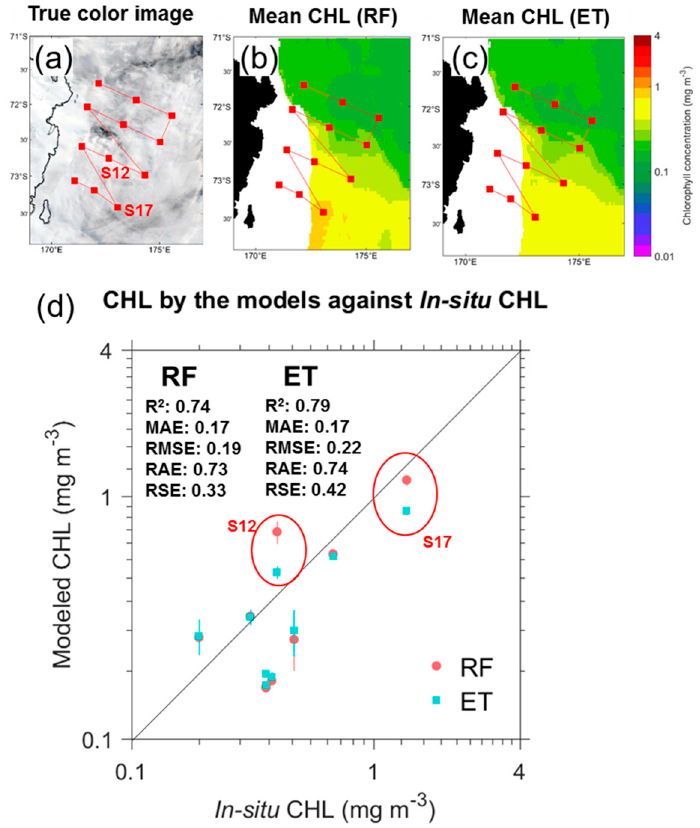
Figure 7. ( a ) True color image on 26 February 2018, with the position of in-situ measurements. Averaged reconstructed CHL from 26 February to 1 March (four days) in: ( b ) the RF model; and ( c ) the ET models ( d ) Comparison between the in-situ and the modeled CHL ( N = 9). The circle is mean values of 5 × 5 pixels, and the vertical bar at each data point is the standard error of the mean.